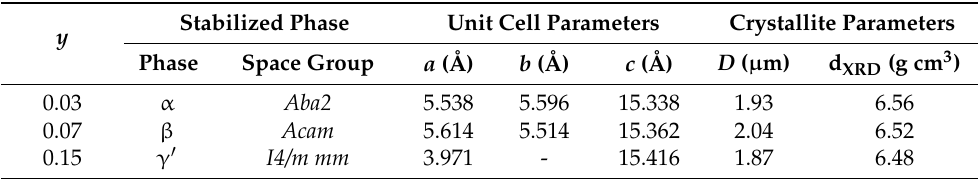
Table 1. Stabilized phase, refined unit cell parameters, crystallite characteristics of as–prepared BiFeVOx.y photocatalyst series.